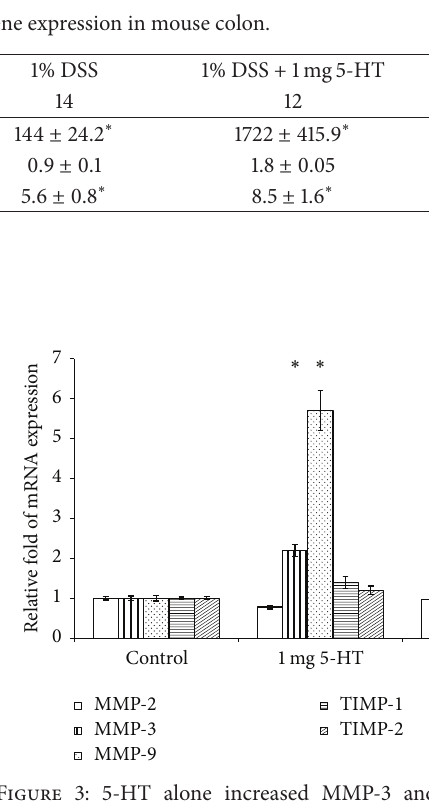
Figure 3: 5-HT alone increased MMP-3 and MMP-9 mRNA expressions in mouse colon. The treatment with low-dose 5-HT increased MMP-9 mRNA expression in mouse colon tissues; high dose only increased MMP-3 mRNA. Neither low- nor high-dose 5- HT increased the expression of MMP-2, TIMP-1, or TIMP-2 mRNA. Results are expressed as the mean ± standard deviations (SD) and 8 mice were included for all three groups. Multiple comparisons among group were done. ∗ 𝑃 < 0.05 versus control mice. § 𝑃 < 0.05 versus 1mg 5-HT